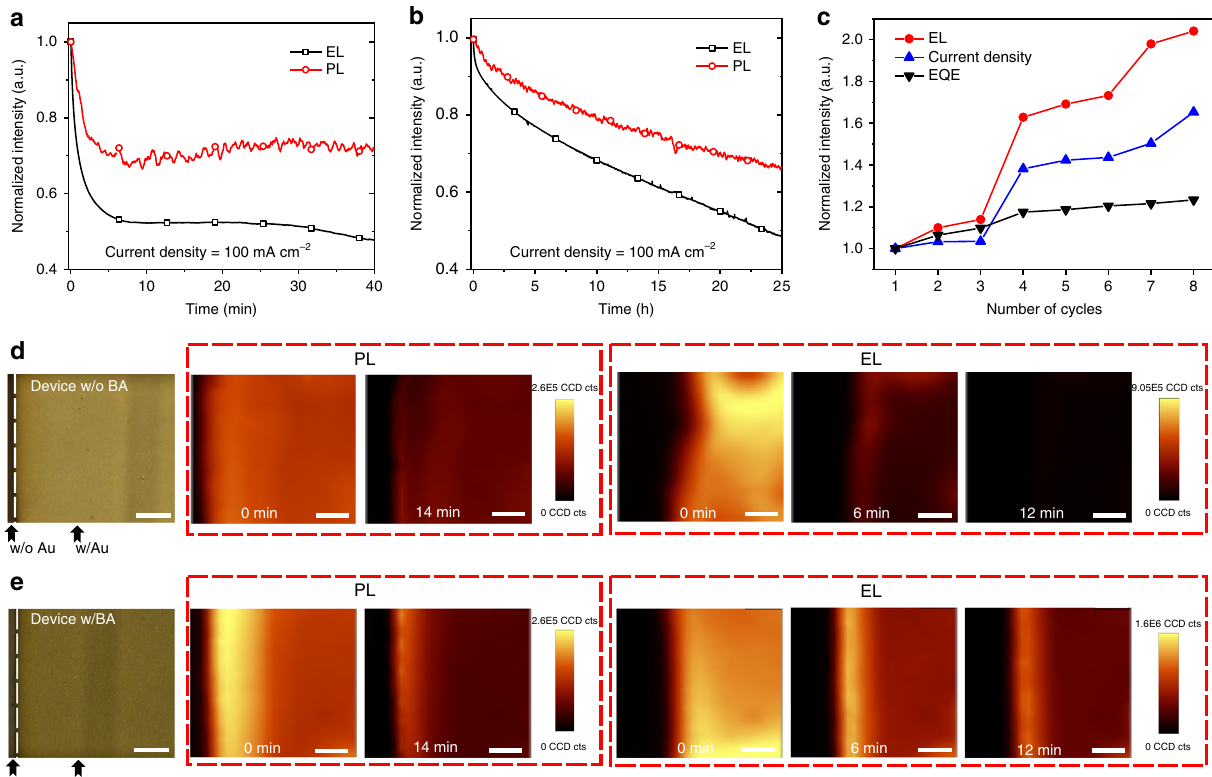
Fig. 2 Optoelectronic characteristics of the aged devices. a EL and PL decay of the 3D PeLEDs without BA treatment at a constant current density of 100 mA cm − 2 . b EL and PL decay of the 3D PeLEDs with BA treatment at a constant current density of 100 mA cm − 2 . c Normalized device EL, current density and EQE under cyclic voltages between − 1 and 2.5 V after aging test. The EL/current density/EQE show recovery. d Microscopy image and corresponding PL and EL intensity maps of device without BA treatment (scale bar, 70 μ m), which show the degradation starts from the edge of Au electrode and the EL degrades faster than the PL. e Microscopy image and corresponding PL and EL intensity maps of device with BA treatment (scale bar, 70 μ m), which show that the BA interfacial layer signi fi cantly suppresses the device